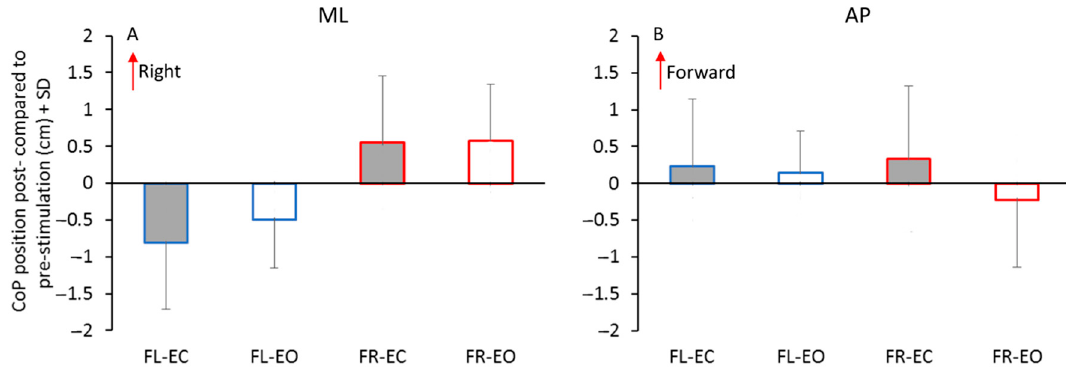
Figure 2. Mean post-stimulation ML ( A ) and anterior–posterior (AP) ( B ) CoP position. The bars with the blue outline refer to the fast left (FL) condition, the bars with the red outline to the fast right (FR) condition. Grey filling refers to EC, white filling to eyes open (EO). ( A ) At the end of the FL stimulation period, the mean ML CoP position moved to the left (negative values in the ordinate) with respect to its pre-stimulation position. At the end of the FR stimulation, the CoP position moved to the right (positive values in the ordinate). ( B ) The post-stimulation CoP position in the sagittal plane (AP) was not different from the pre-stimulation position.